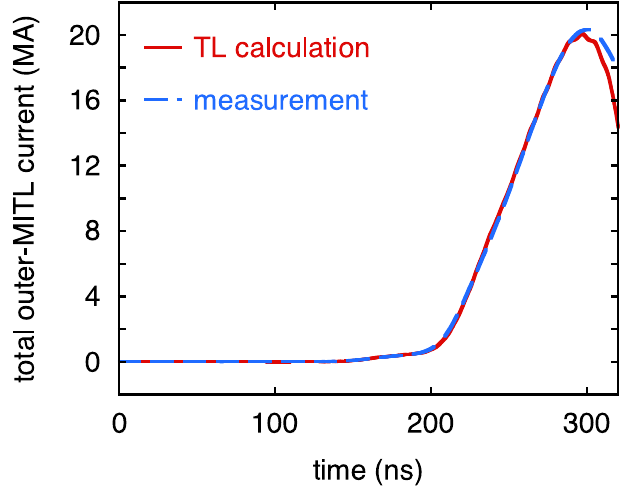
FIG. 9. (Color) Comparison of the TL -calculated total outer- MITL current, with the average measured total outer-MITL current, for the seven shots taken with Z ’s baseline load. (The average is computed by summing, for each shot, the outer-MITL current over each of the four levels for each shot, then taking an average over the shots.)